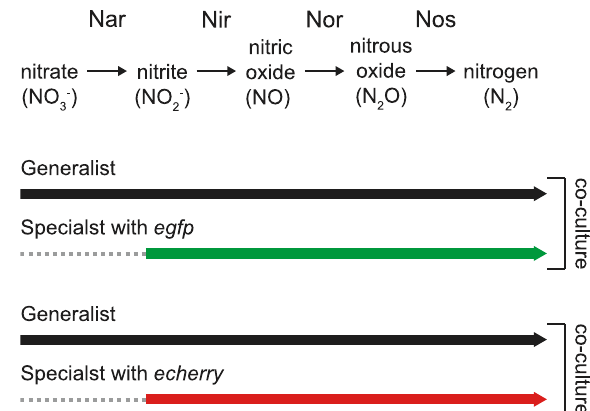
Fig. 2 Experimental system used in this study. Our system consists of three isogenic strains of P. stutzeri . The generalist has the complete denitri fi cation pathway and can reduce nitrate to nitrogen gas. The two specialists have a single loss-of-function mutation in the narG gene and can reduce nitrite to nitrogen gas but cannot reduce nitrate to nitrite. The two specialists are genetically identical except that they have a chromosomally located green ( egfp ) or red ( echerry ) fl uorescent protein-encoding gene. When the generalist is grown together with one of the two specialists under anoxic conditions and with nitrate as the growth-limiting substrate, the generalist preferentially consumes nitrate to nitrite while the specialist consumes the released nitrite. Thick arrows indicate the nitrogen oxides that can be consumed by each strain. Nar nitrate reductase, Nir nitrite reductase, Nor nitric oxide reductase, Nos nitrous oxide